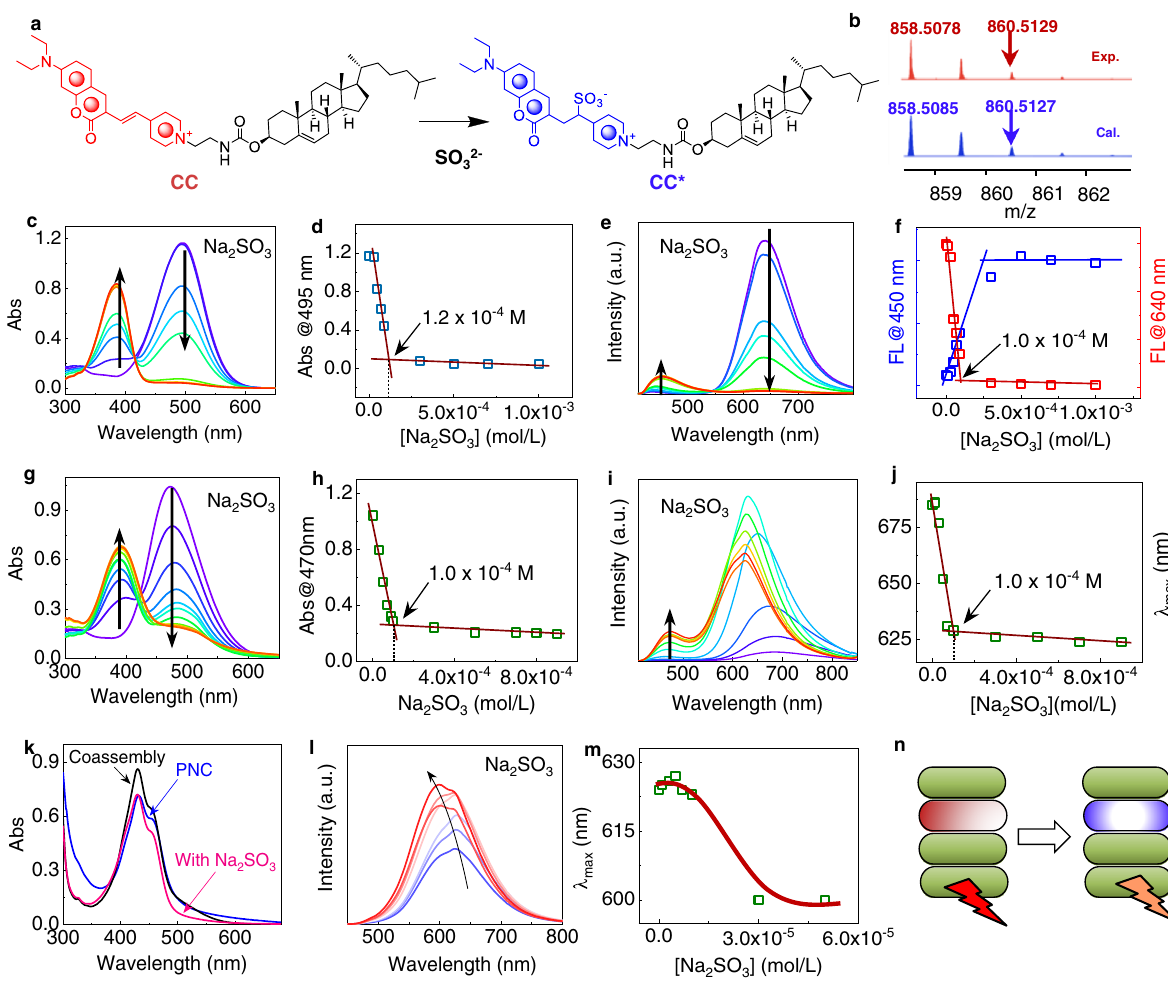
Fig. 5 Variations of UV – Vis absorption and fl uorescent emission spectra treating with Na 2 SO 3 . a Reaction of CC with Na 2 SO 3. b Comparison of HRMS about CC treated with Na 2 SO 3 (5 molar eq.) with stimulated pro fi le. c UV – Vis absorption and d corresponding vibration of absorption at 495 nm of CC (10 − 4 M) with various concentrations of Na 2 SO 3 . e Fluorescent emission spectra and f corresponding vibration of emission intensity at 450 and 640 nm of CC (10 − 4 M) with various concentrations of Na 2 SO 3 in THF (10 vol% water was added to dissolve Na 2 SO 3 ). g UV – Vis absorption and h corresponding vibration of absorption at 470 nm of CC (10 − 4 M) with various concentrations of Na 2 SO 3 . i Fluorescent emission spectra and j corresponding vibration of the maximum emission wavelength of CC assembly (10 − 4 M) with various concentrations of Na 2 SO 3 in THF/H 2 O = 1/9. k UV – Vis absorption comparison of PNC, CC, PNC/CC and PNC/CC/Na 2 SO 3 assemblies. l Fluorescent emission spectra and m corresponding vibration of maximum emission wavelength of PNC/CC coassemblies ([PNC] = 10 − 4 M, [CC] = 10 − 5 M) with various concentration of Na 2 SO 3 (THF/H 2 O = 1/9, excited at 380 nm). n A schematic model for color changing responding to the anion, where green, red and blue rods stand for PNC, CC, and CC*